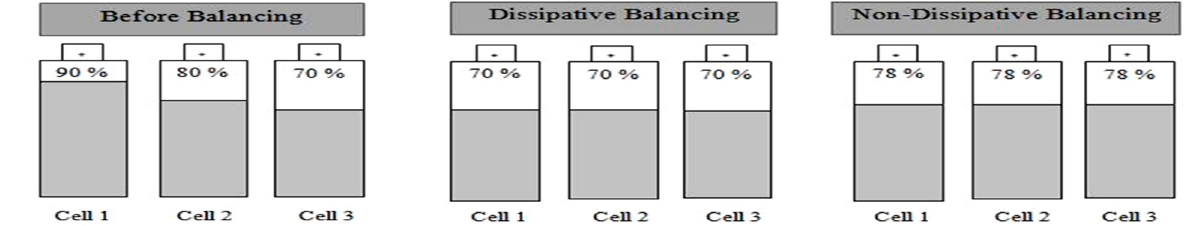
Figure 8. Comparison between active and passive cell balancing [33].